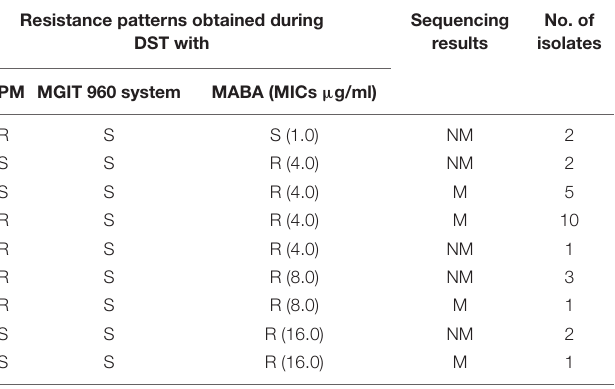
TABLE 2 | Analysis of isolates with discordant results between the PM/MGIT 960 system and MABA. Resistance patterns obtained during DST with